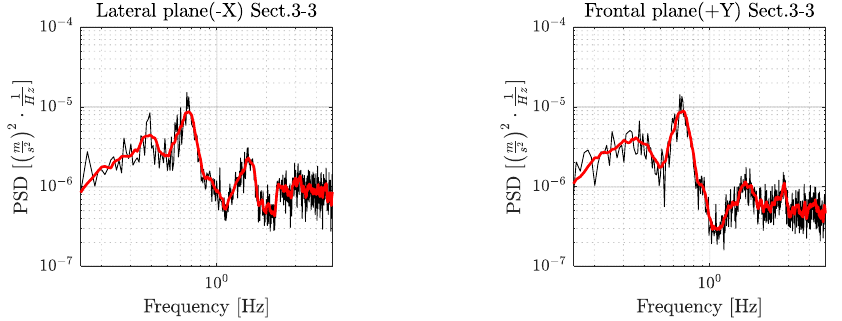
Figure 7. Comparison between the PSDs estimated on the entire signal (black) and the PSDs ob- tained by averaging the signal (red).